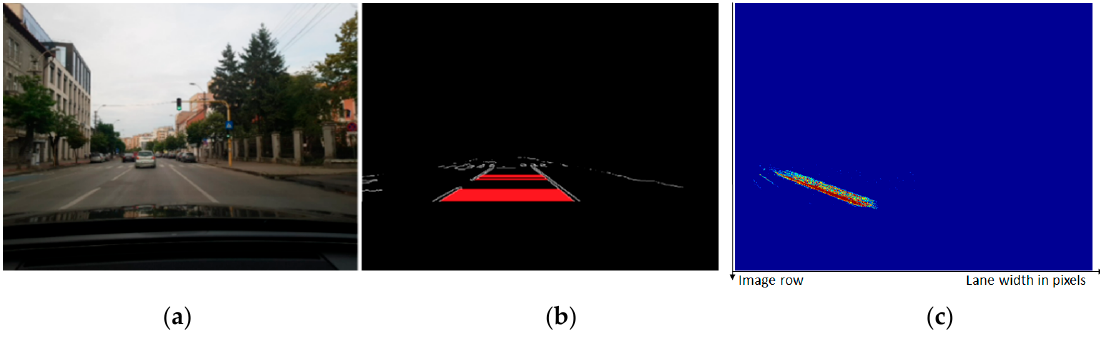
Figure 9. Finding the linear dependency between the lane width in the perspective image and the image row: ( a ) Perspective image, ( b ) detected lane widths, and ( c ) voting matrix counting lane width and image row pairs, shown as a heat map.